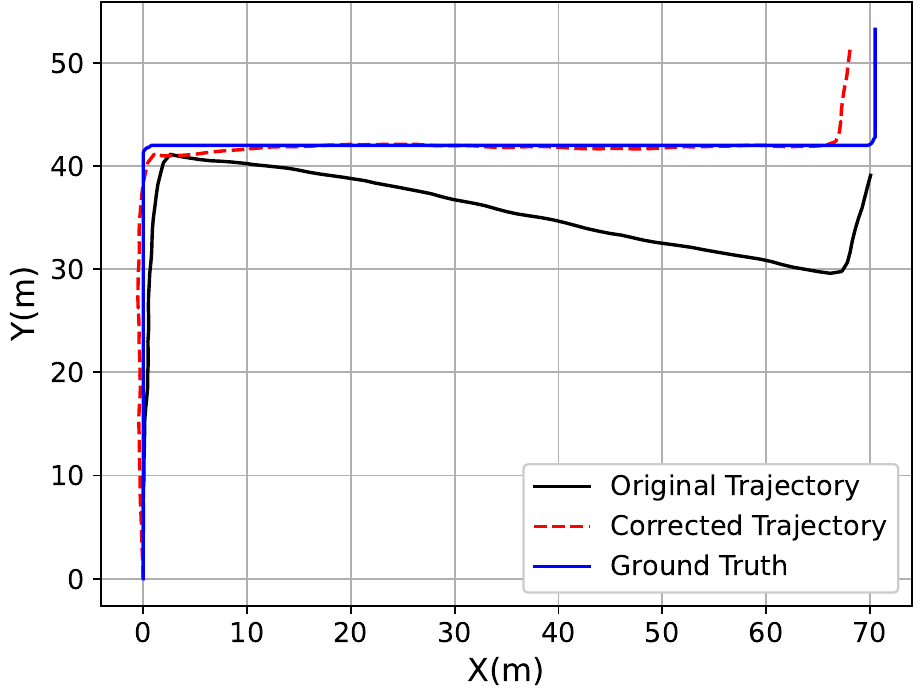
Figure 9. Comparison with the ground truth and corrected